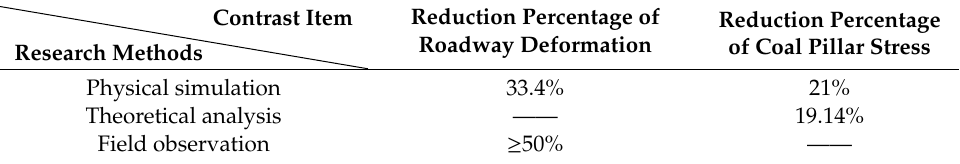
Table 3. Summary of the results of different research methods.